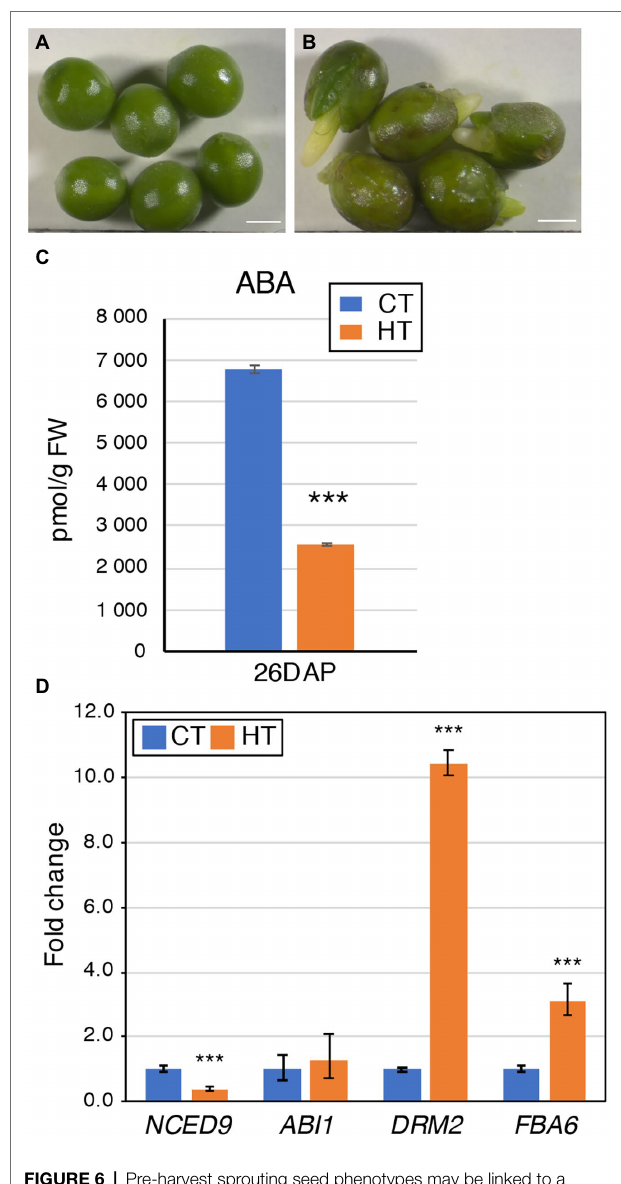
FIGURE 6 | Pre-harvest sprouting seed phenotypes may be linked to a decrease in ABA levels. (A,B) Topas 26 DAP seeds grown at CT (A) and HT (B) . Notice the sprouting of the seeds (B) , with the emergence of either root or cotyledons. Scale bars represent 1 mm. (C) Graph showing the ABA levels (in pmol/g FW) in Westar 26 DAP seeds grown at CT and HT. Shown is the average ± SD. Asterisks indicate a statistically significant difference in HT in a paired Student’s t -test ( t -test; *** corresponds to value of p < 0.001). Source data are presented in Supplementary Table S4 . (D) Expression analysis by RT-qPCR of BnaNCED9 , BnaABA1 , BnaFBA6 , and BnaDRM2 in Westar 26 DAP seeds. The graph displays the fold changes in expression between CT (blue) and HT (orange). Asterisks indicate a statistically significant difference in HT in a paired Student’s t -test ( t -test; *** corresponds to value of p < 0.001). Primers and LOC information are presented in Supplementary Table S1